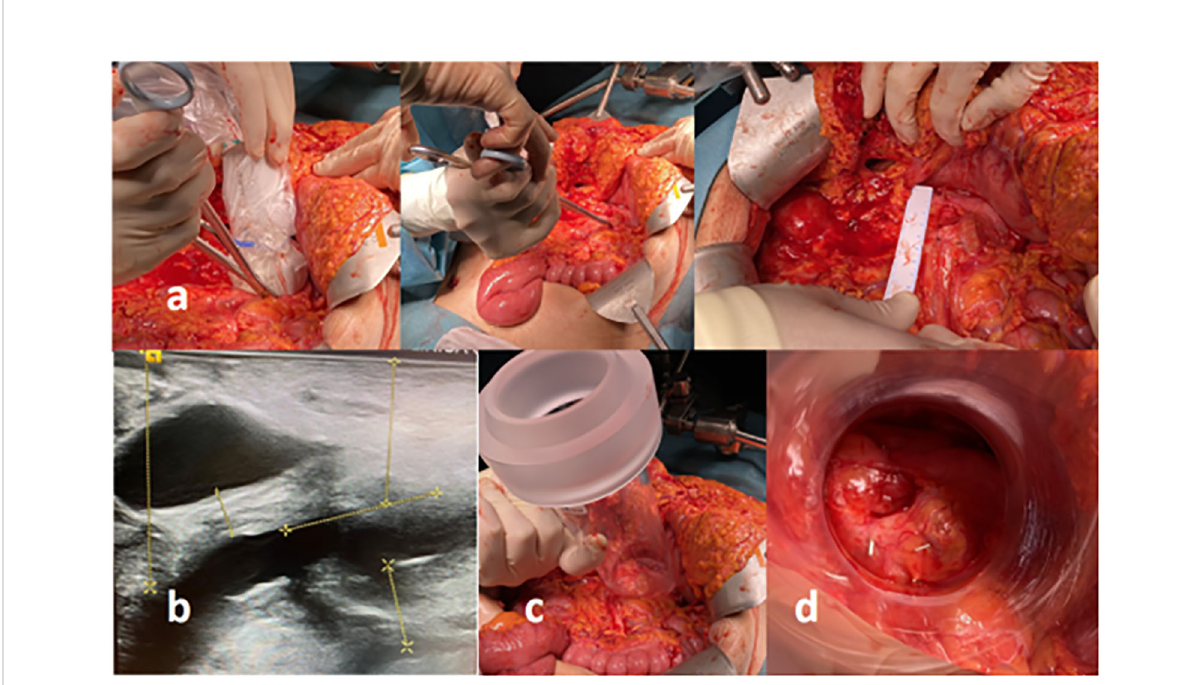
FIGURE 7 Combined surgical and IOeRT procedure in a patient with unresectable cancer of the body of the pancreas with 360° involvement of the superior mesenteric artery explored and treated after intense neoadjuvant therapy and complete metabolic remission (including tumor markers normalization). (A) Surgical maneuvers to guide the IOeRT procedure (ultrasound delimitation of residual abnormalities; target de fi nition with surgical clips; measurements for applicator selection. (B) Ultrasound measures for electron energy, applicator size selection, and the effect of the displacement of the duodenum from the target by the use of a spacer. (C) External view of the surgical fi eld and IOeRT applicator positioning. (D) Beam ’ s eye view of the target (notice the margin around the markers fi xed at the time of intraoperative ultrasound